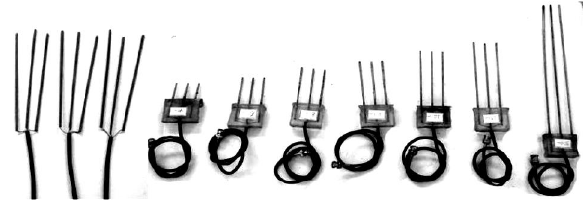
Figura 1. Exemplares de sondas de TDR utilizadas no